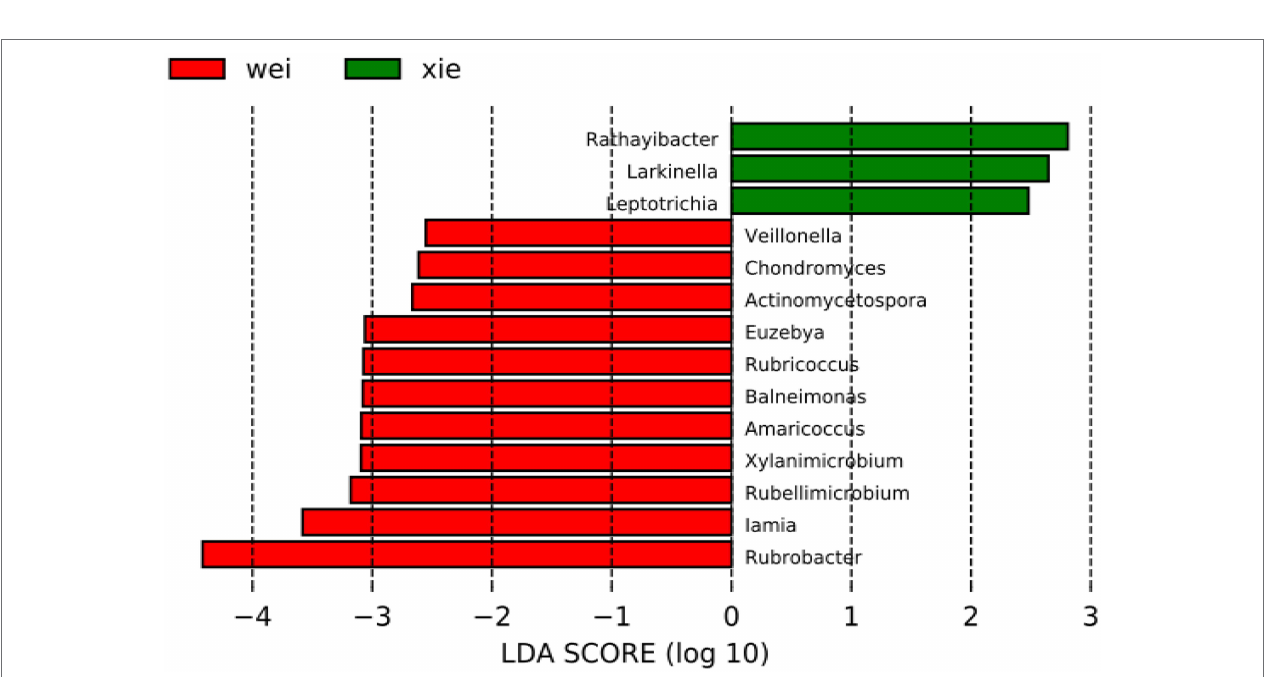
FIGURE 4 | A redundancy analysis (RDA) was used to analyze the impact of the soil nutritional elements (NO 3 − -N, NH 4+ -N, TN, TC, TS, Fe, and TP) on the bacterial and actinobacterial communities. The blue arrows indicate the correlation between the nutritional elements and the bacterial (A) or actinobacterial (B) community structure. A Monte Carlo permutation test was used to evaluate the significance of these correlations.